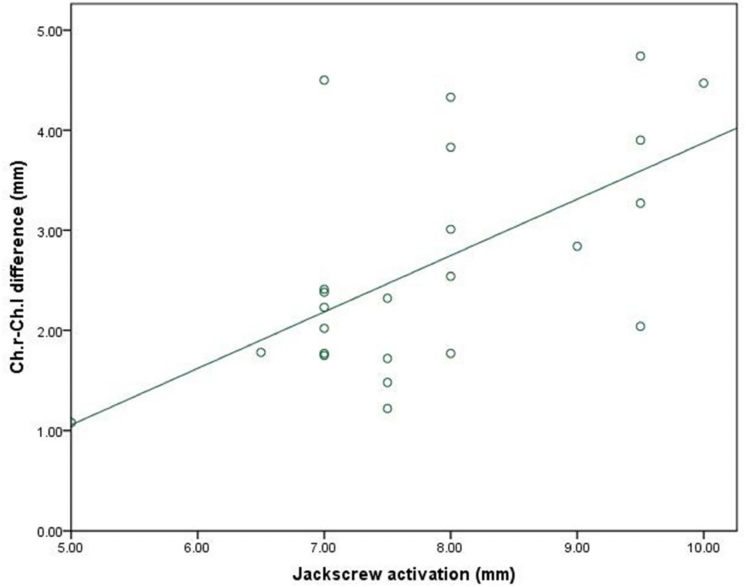
Figure 8. Scatter plot for the correlation between the mouth width difference and the jackscrew activation